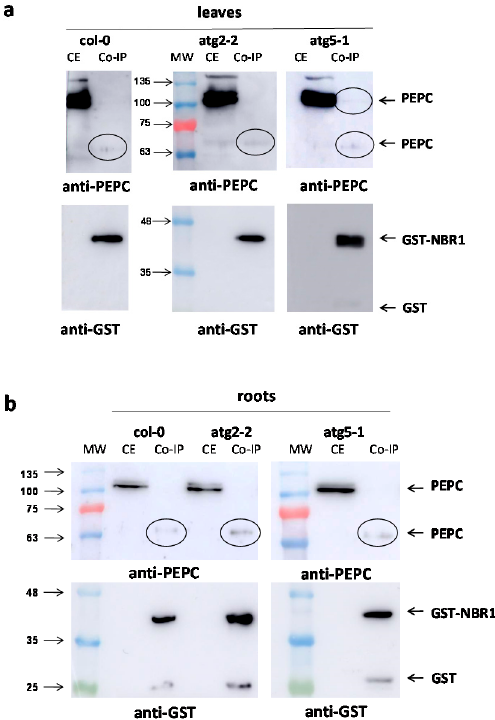
Figure 7. Co-immunoprecipitation of PEPC with GST-NBR1 in Arabidopsis lines. Crude extracts from leaf ( a ) and root ( b ) tissues of Col-0, atg2 , and atg5 Arabidopsis (six weeks) were incubated overnight at 4 °C with purified GST-NBR1 pre-bound to Gluthatione Sepharose ® 4B (GE Healthcare). Then, extracts were centrifuged at 1000× g for 2 min at 4 °C, washed five times, and co-precipitated proteins were eluted by heating at 95 °C for 5 min with a dissociation buffer. After- wards, 50 µg of proteins from crude extracts (CE) and corresponding amounts of co-precipitated proteins (Co-IP) were analyzed by SDS-PAGE and immunoblotted with anti-PEPC and anti-GST antibodies.